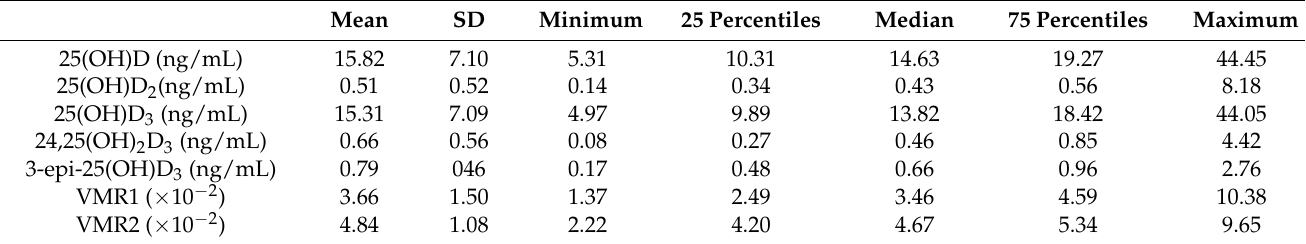
Table 3. Levels of Vitamin D metabolites in maternal blood.